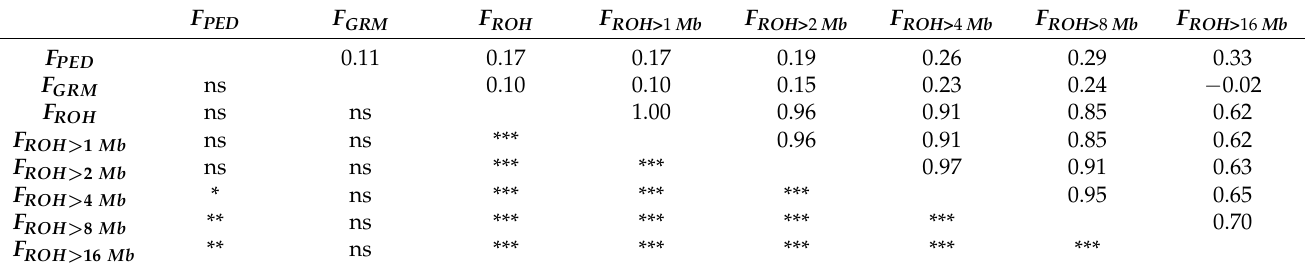
Table 4. Pearson’s correlations (above diagonal) among genomic- ( F GRM ), pedigree- ( F PED ), and Runs of Homozygosity- ( F ROH ) based inbreeding coefficients; significance values 1 are reported below diagonal.